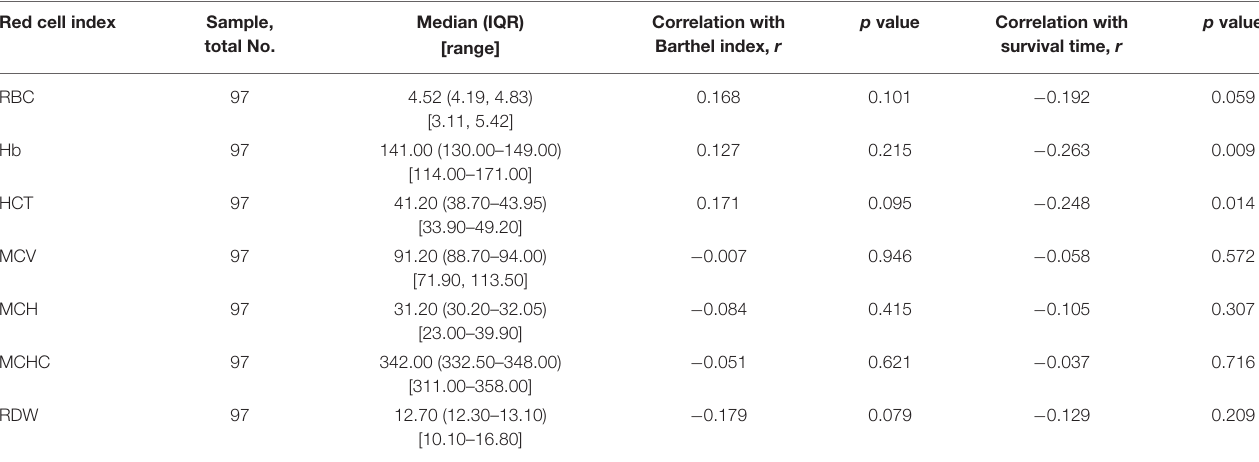
TABLE 2 | Red cell indices and cohort characteristics of deceased patients.